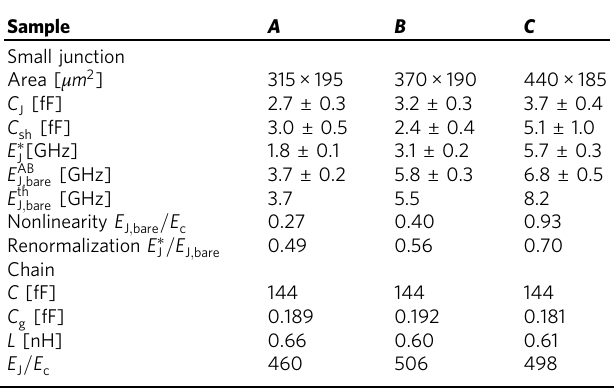
Table 1 Parameters of three samples. The bare Josephson energy E AB is inferred using the Ambegaokar – Baratoff law. J ; bare E (cid:1) is the measured value of the renormalized Josephson J energy. As a consistency check, the bare value E th is also J ; bare extracted from the fi t of E (cid:1) using the SCHA. C is the sh J capacitance shunting the small Josephson junction (see Supplementary Note 9). C , C , and L are obtained from the g dispersion relation of the chain (see Supplementary Note